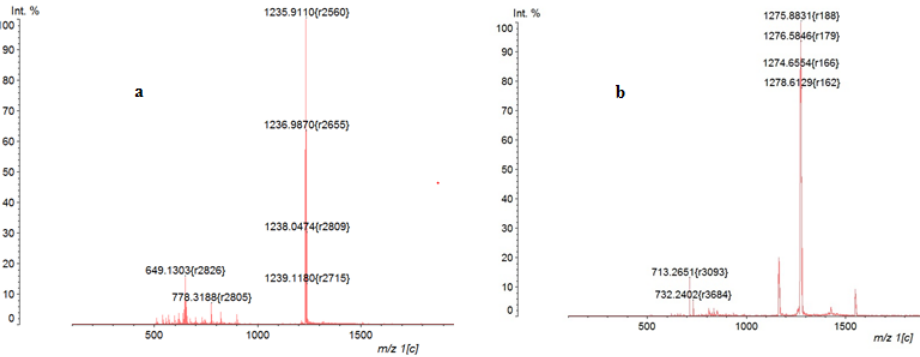
Figure 2. Mass spectra of compounds 1 ( a ) and 2 ( b ).